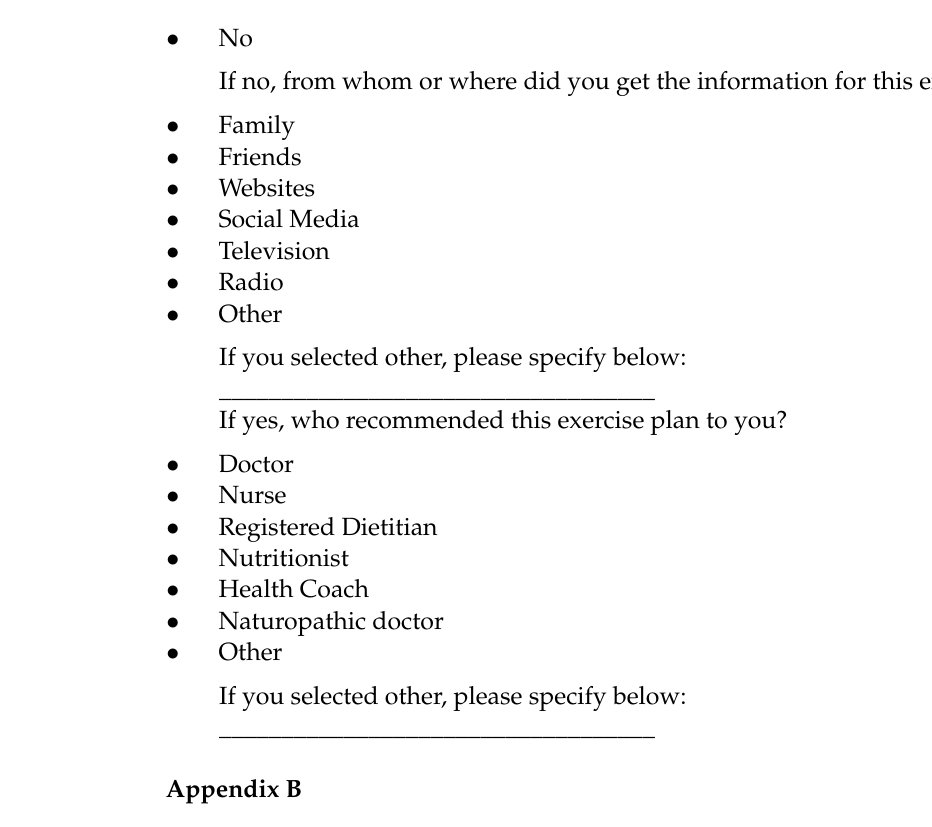
Table A1. Sources of information for diet and physical activity plans followed by women with polycystic ovary syndrome—findings from content coding of written